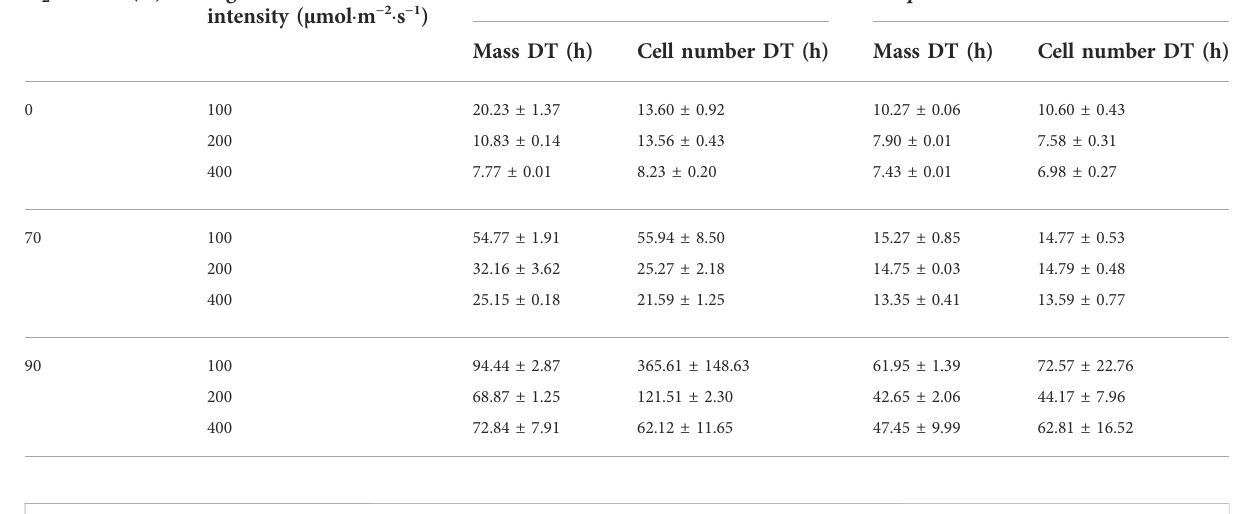
TABLE1Massandcelldoublingtimes(DT)of C.reinhardtii and D.quadricauda indifferentcombinationsofD 2 Oandlightintensities.Values aregiven as mean ± standard deviation ( n = 3). D 2 O conc. (%)